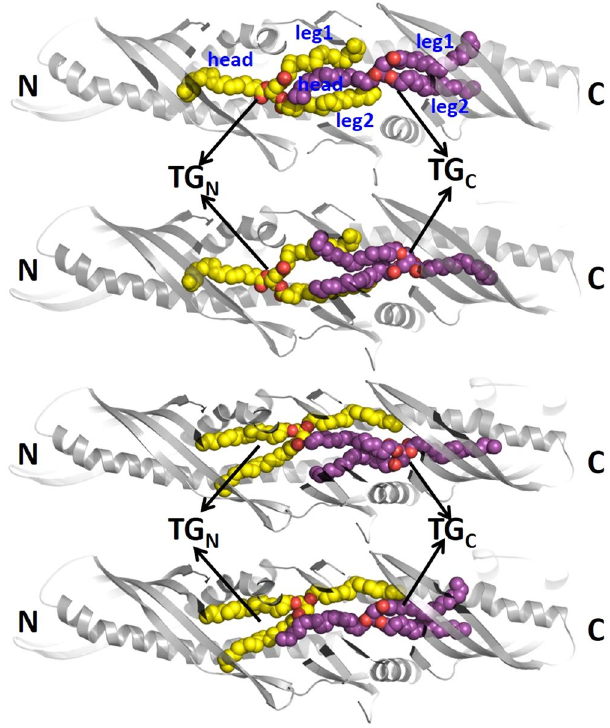
Figure 2. Possible orientations of two docked TG molecules in CETP core tunnel: ( a ) “parallel N-N” orientation with both TGs orienting head-to-legs from N- to C-terminal of CETP, ( b ) “antiparallel N-C” orientation with N-terminal TG (TG N ) orienting head-to-legs from N- to C-terminal, and C-terminal TG (TG C ) orienting head-to-legs from C- to N-terminal of CETP, ( c ) “parallel C-C” orientation with both TGs orienting head-to-legs from C- to N-terminal of CETP, ( d ) “antiparallel C-N” orientation with TG N orienting head-to-legs from C- to N-terminal and TG C orienting head-to-legs from N- to C-terminal of CETP. TG N is shown in yellow and TG C in purple. Oxygen atoms in TG N and TG C are shown in red. CETP is shown in gray